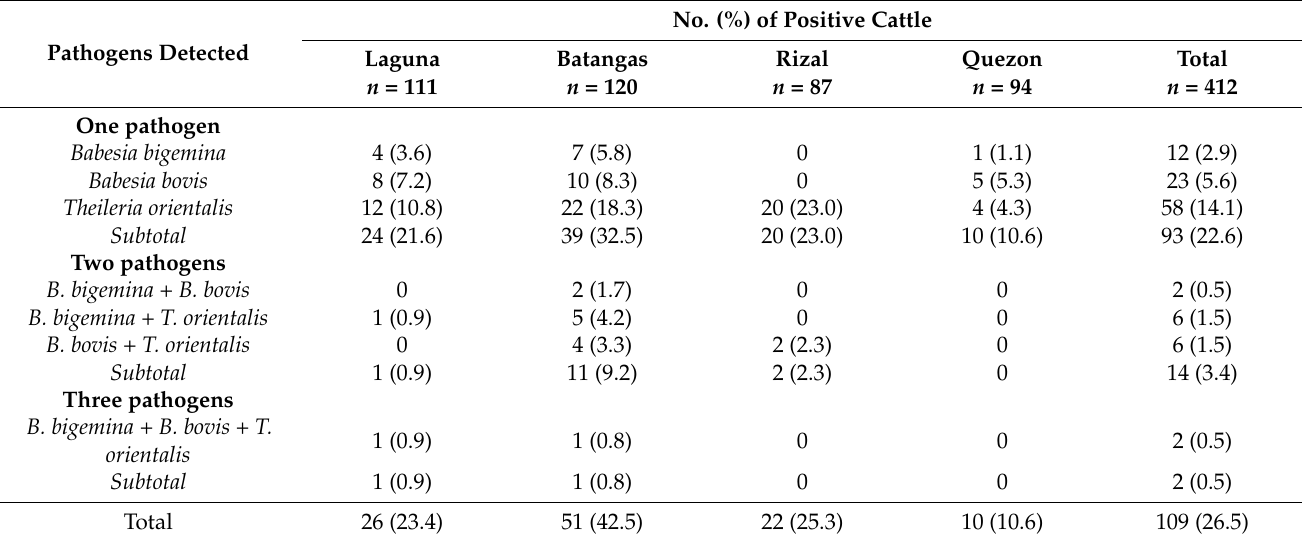
Table 2. Number and percent (%) of blood samples in cattle from selected provinces in Luzon, Philippines, that tested positive for Babesia bigemina, Babesia bovis, and/or Theileria orientalis based on species-specific PCR. n = total number of blood samples.